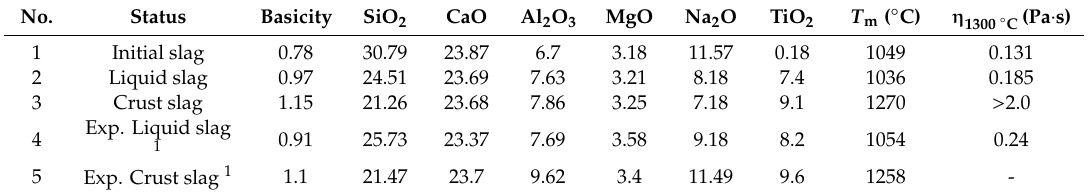
Table 5. Main compositions (wt. %) and properties of slags following steel-slag reaction.